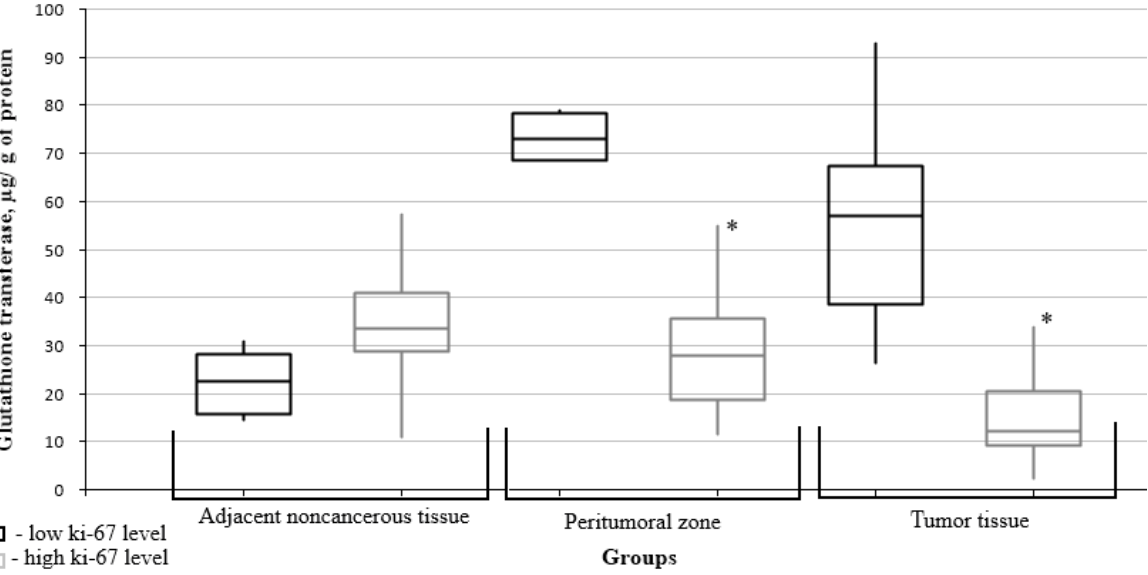
Figure 6. Medians and interquartile ranges (IQRs) of glutathione S-transferase levels in gliomas as a function of the Ki-67 mitotic index value. There are significant differences between the glutathione transferase levels in the peritumoral zone tissues (* ̵ Mann-Whitney U-test p = 0.007) and the tumors (* ̵ Mann-Whitney U-test p = 0.010) for the low and high mitotic index Ki-67 groups. The content of reduced glutathione in the tumor tissues of patients with gliomas and the IDH1 mutation was significantly higher than in the wild-type IDH1 group (Figure 7).